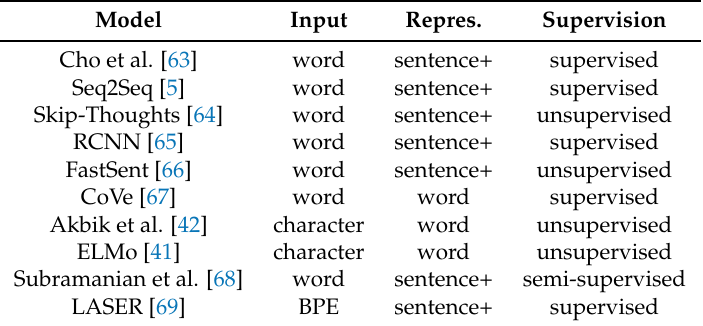
Table 2. The categorization of recurrent models by input level, representation level, and supervision. BPE stands for byte pair